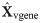
A stacked barplot of the estimated parameter values of α from the best regularized L2 model.For convenience, we aggregate the estimates of α associated with X^vgene and X^vsubgrp (blue) and with X^naiveAA and X^neut (red). The black vertical lines represent the boundaries between the different CDRs and FWKs.